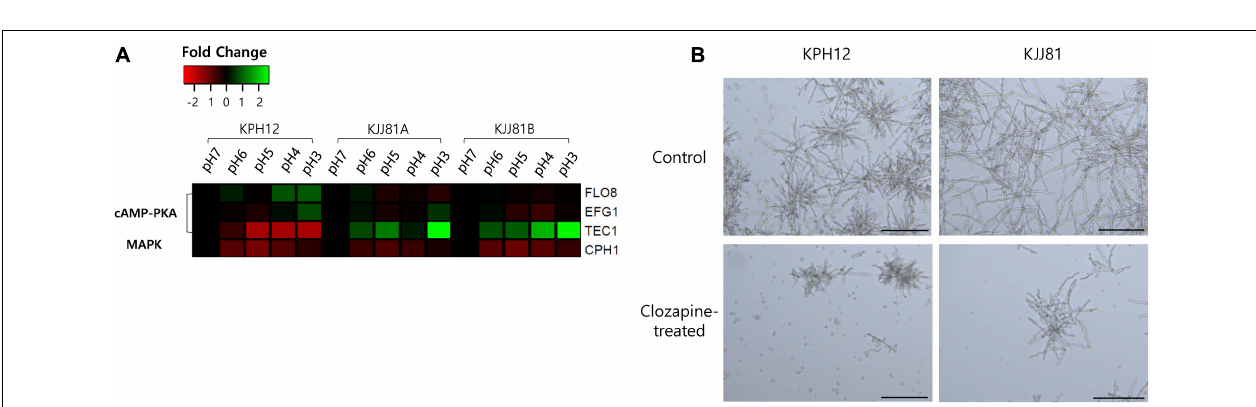
FIGURE 8 | Expression profiles of Saccharomycopsis fibuligera genes associated with starch and cellulose degradation as well as the transcription factor RIM101. (A) Genes encoding the hydrolytic enzymes were analyzed using the data from RNA-Seq for their expression at the five pH values and presented as a heat map. pH 7 was considered the starting point (log 2 FC = 0), and the expression change at each pH was calculated based on pH 7. SD, starch degradation; CD, cellulose degradation; TF, transcription factor. (B) qRT-PCR analysis. To confirm the results obtained from the RNA-seq data, a qRT-PCR assay was performed for the indicated genes using specific primers. Error bar, standard deviation ( n = 3).